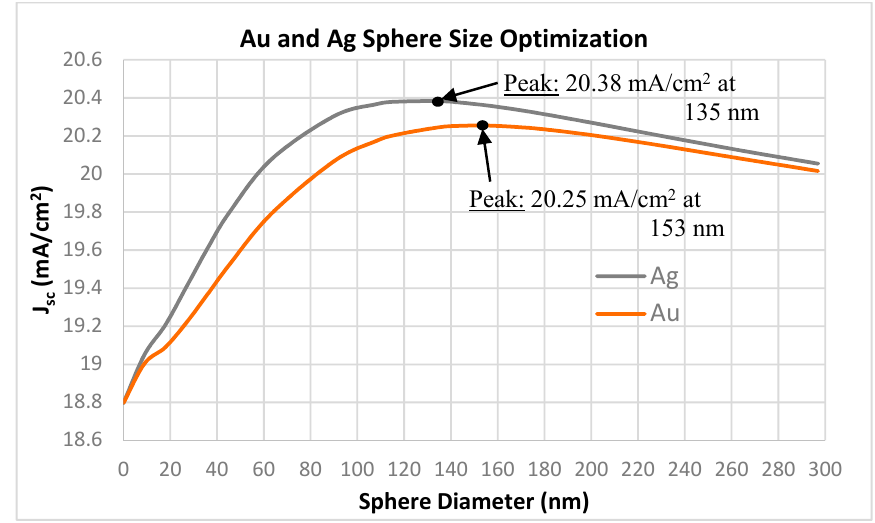
Figure 5. Solar cell J sc vs. Ag and Au nanosphere diameter, indicating the peak for each.